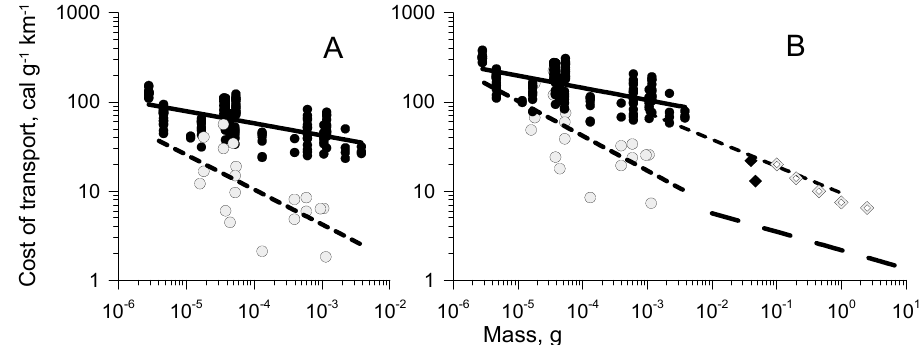
Figure 19. ( A ): Maximum mechanical cost of transport ( C tm ) during escape reaction ( ● ) and cruising ( ○ ). ( B ): Metabolic cost of transport (C tb ) and values for swimming fish (long dashed line) and flight of insects (short dashed line) [78]; escape reaction of shrimp (unshaded diamond) [88] and Euphausia (black diamond) [89].